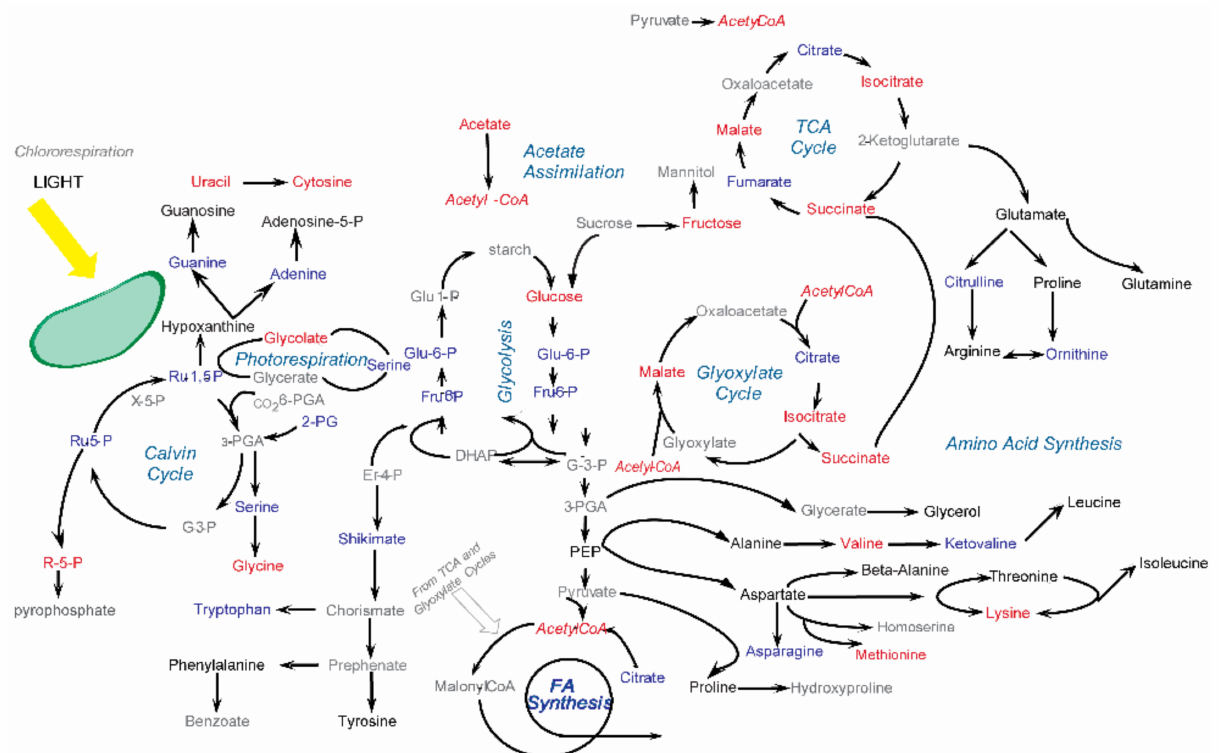
Figure 3. Metabolic pathway summarizing the compound-induced changes in the C. reinhardtii metabolome identified by NMR and GC-MS (metabolites of interest). Metabolites that were only identified by NMR are colored blue. Metabolites that were only identified by GC-MS are colored red. Metabolites identified by both methods are colored black, and metabolites not identified are colored grey. The total numbers of metabolites of interest within these metabolic pathways that were identified by either NMR, GC-MS, or both techniques were 14, 16 and 17 metabolites, respectively. Reprinted with permission from Ref. [134]. Copyright 2018 American Chemical